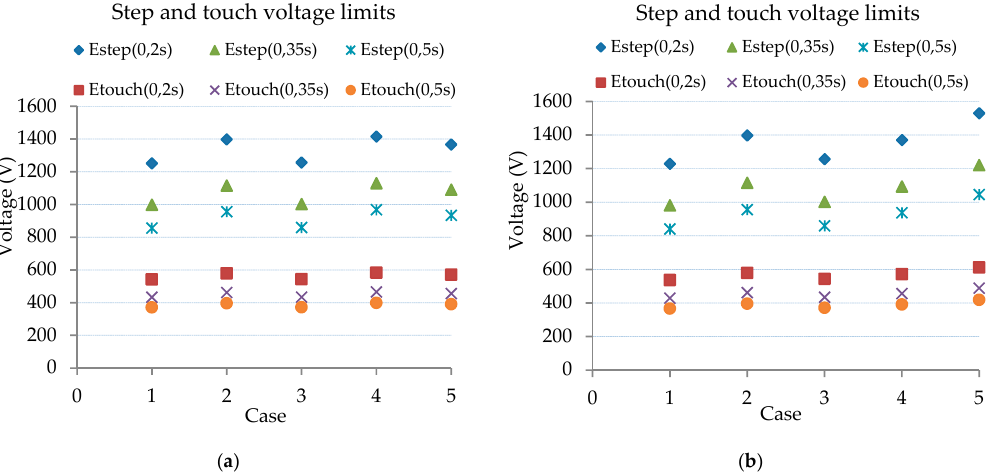
Figure 4. ( a ) Variation of the maximum permissible limits for step and touch voltages with respect to the resistivity measuring axes (two-layer); ( b ) variation of the maximum permissible limits for step and touch voltages with respect to the resistivity measuring axes (three-layer).